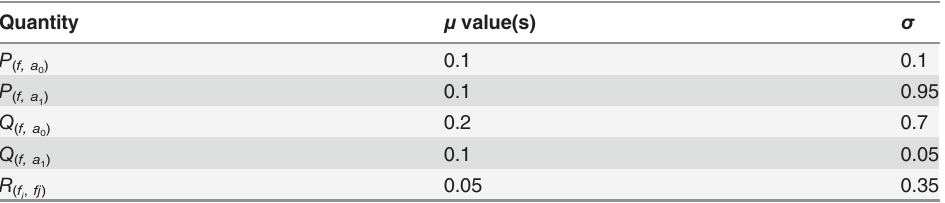
Table 1. Default values of μ and σ used for Gaussian distributions of simulation probabilities throughout this work.